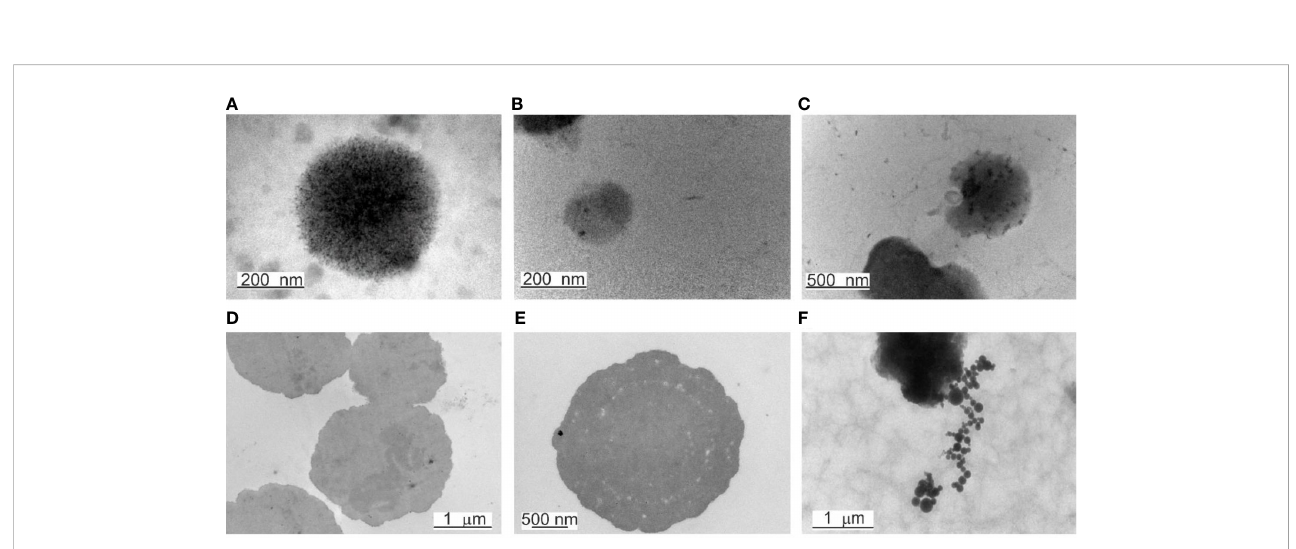
FIGURE 5 TEM of elementary bodies and electron-dense bodies. (A) A mossy elementary body. (B) Elementary body of 180 – 200 nm in size. (C) Extrusion of an elementary body. (D, E) Large electron-dense bodies, named also “ mother ” cells. (F) In chains proliferation of electron-dense bodies.